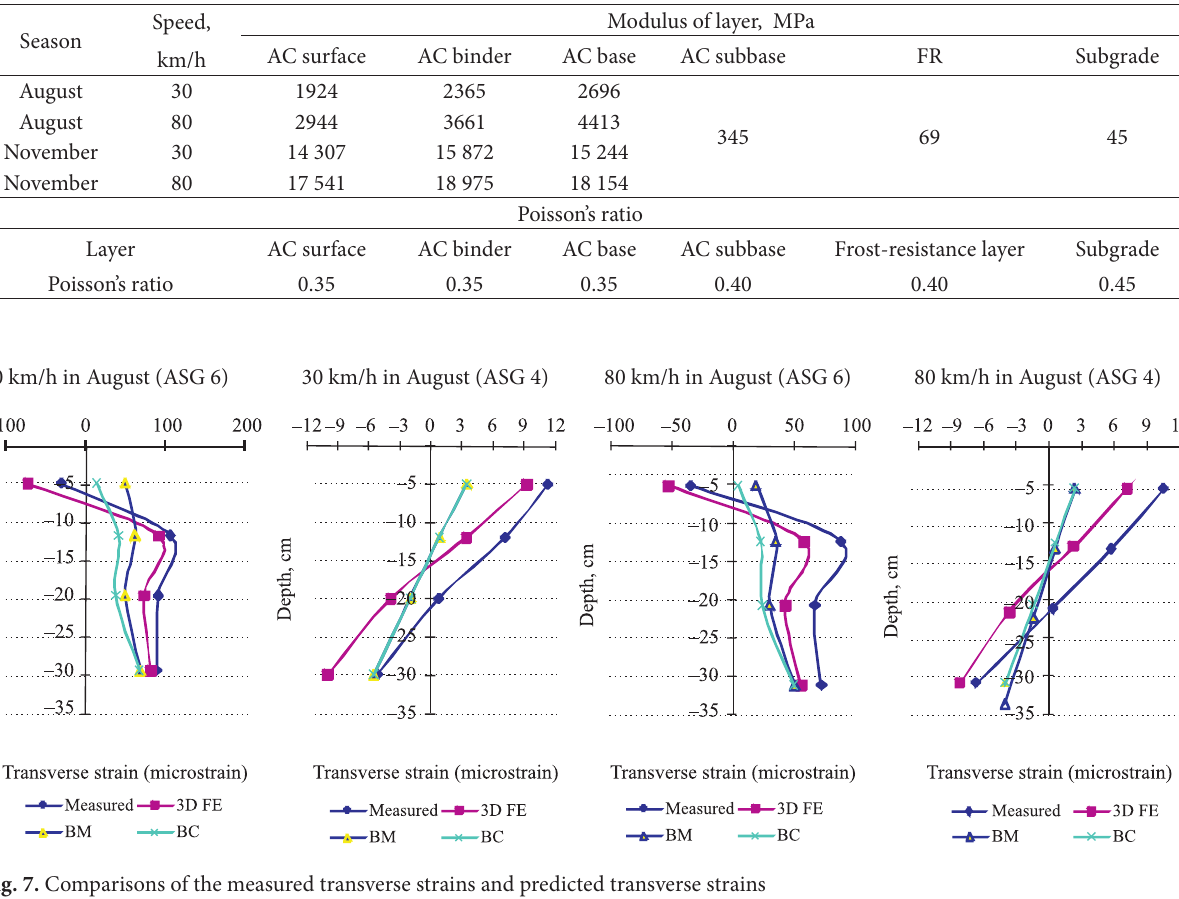
Fig. 7. Comparisons of the measured transverse strains and predicted transverse